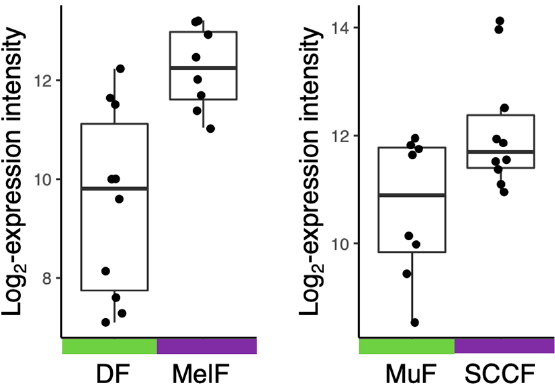
Figure 1. Expression of the IL6 gene in stromal elements of melanoma and head and neck squamous cell carcinoma (HNSCC). Normal dermal fibroblasts (DF, left panel) and normal mucous fibroblasts (MuF, right panel) express lower quantities of IL-6 mRNA than cancer-associated fibroblasts isolated from melanoma (MelF, left panel) or HNSCC (SCCF, right panel).